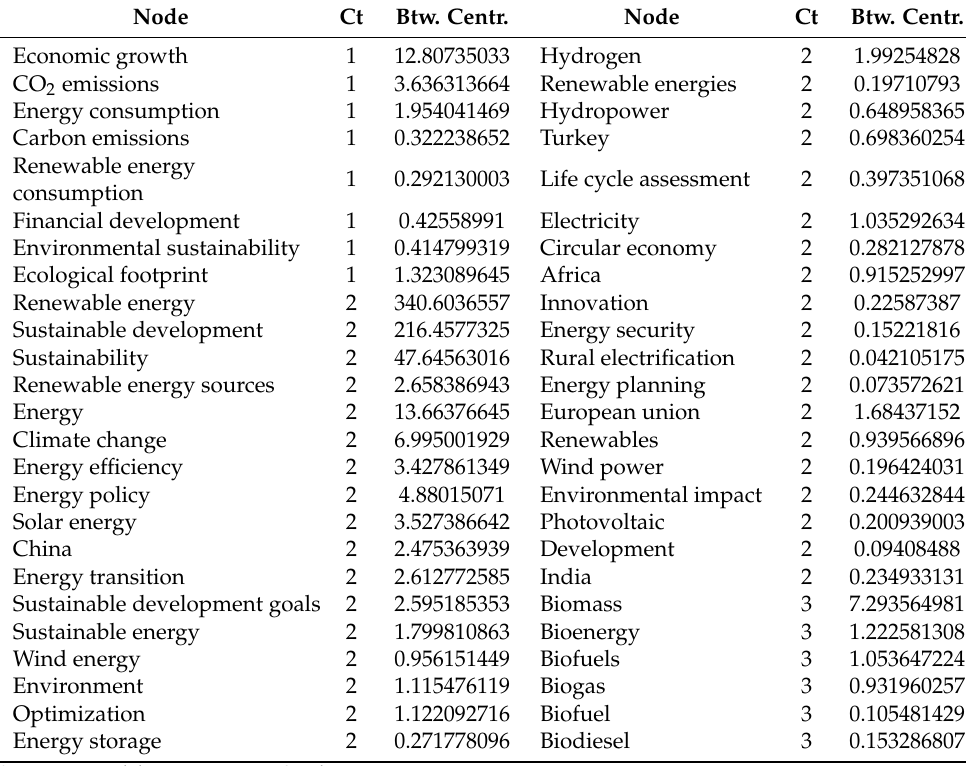
Table 10. Co-occurrence network: betweenness centrality.